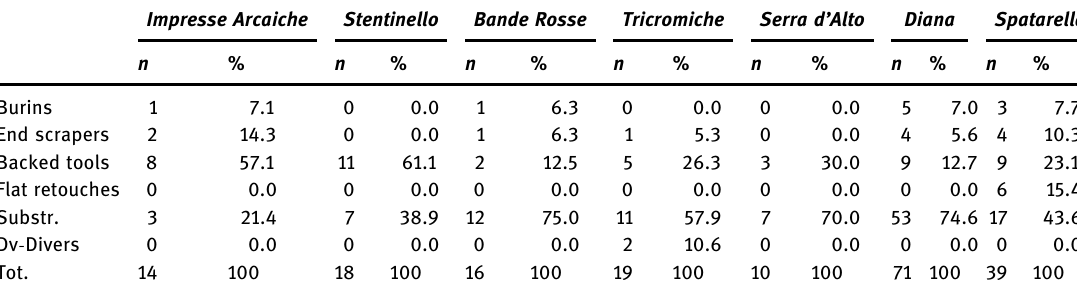
Table 3: Typological description of the Neolithic assemblage Impresse Arcaiche